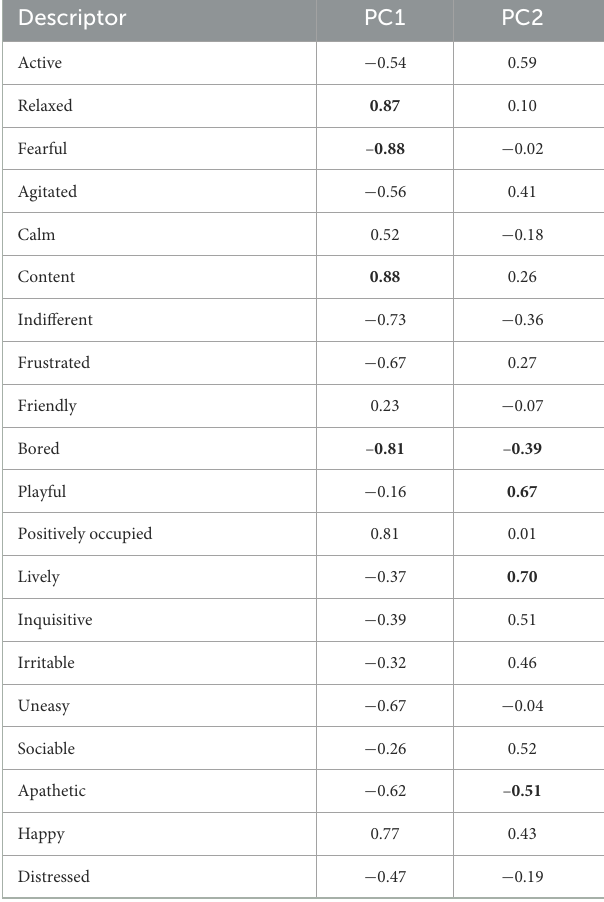
TABLE 1 Group 1: Principal components 1 and 2, displaying associated correlations between variables and principal components for each behavioural